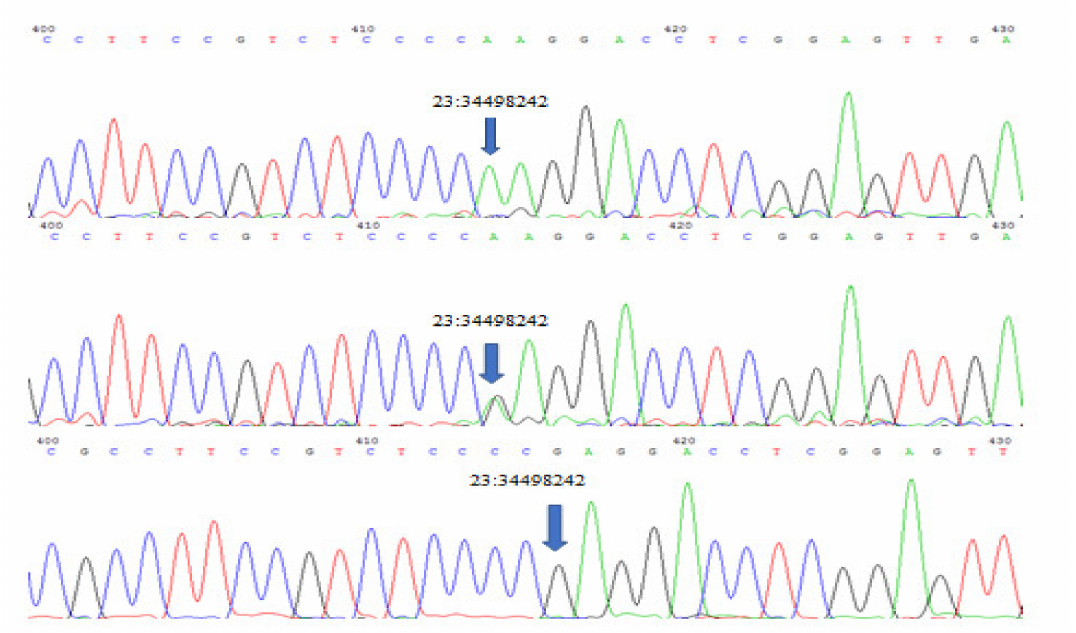
Figure 2. Three genotypes were detected at genomic locus: 23:34498242, 5606 bp (relative to the gene size) in GATA6 Exon 7 GA, AA and